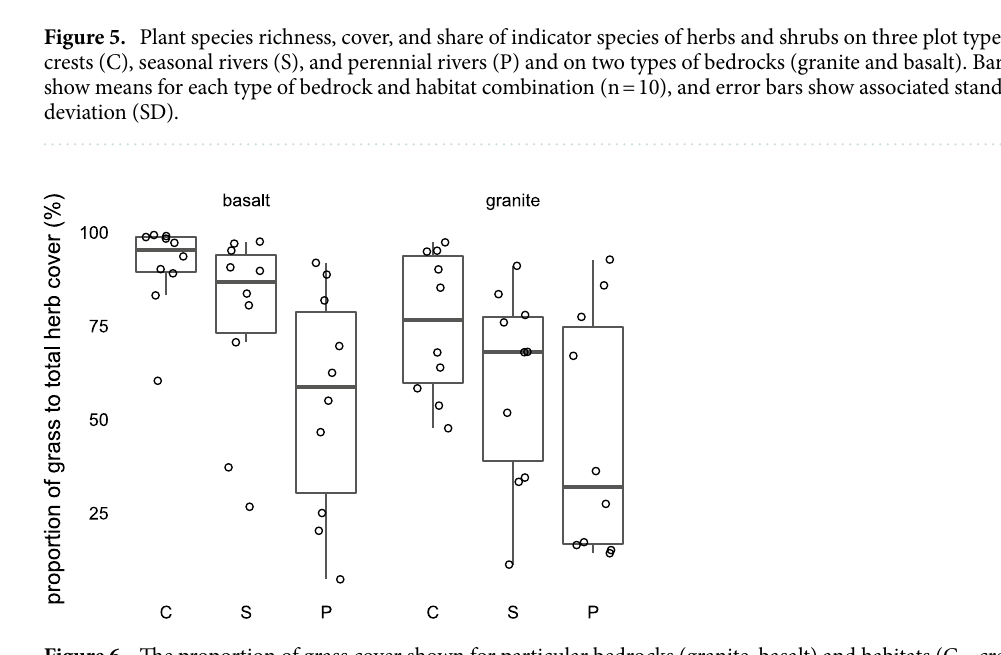
Figure 6. The proportion of grass cover shown for particular bedrocks (granite, basalt) and habitats (C—crest, S—seasonal river, P—perennial river). Based on the sums of percentage covers of all species in the herb layer of a plot, expressed separately for grasses and